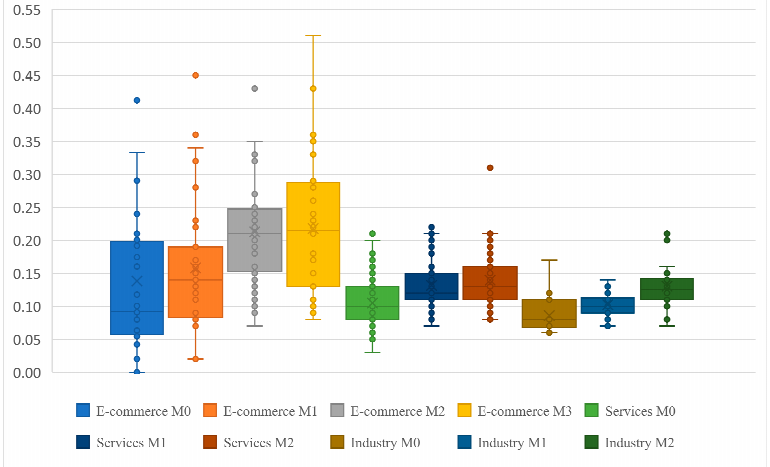
Figure 4. Box-plots for values of the Spc indicator for e-commerce, services, and industry.